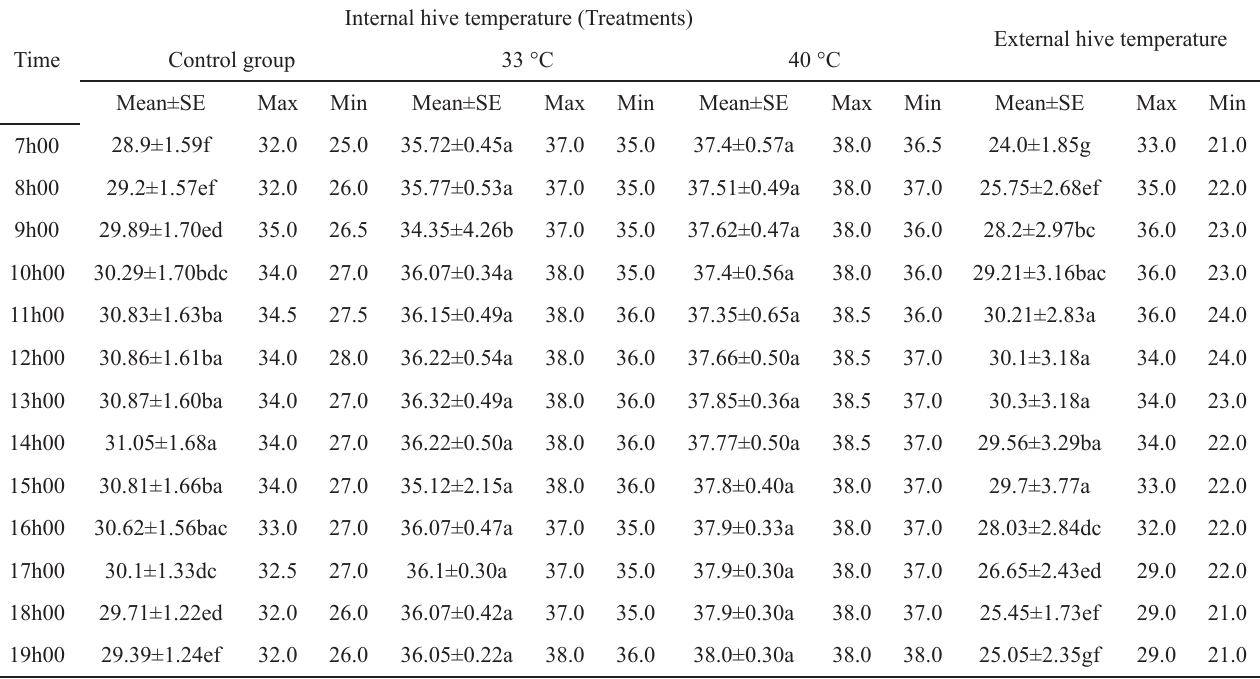
Table 1 . External and internal hive temperature of Apis mellifera colonies exposed to natural environmental (control group) and to controlled temperatures of 33 and 40